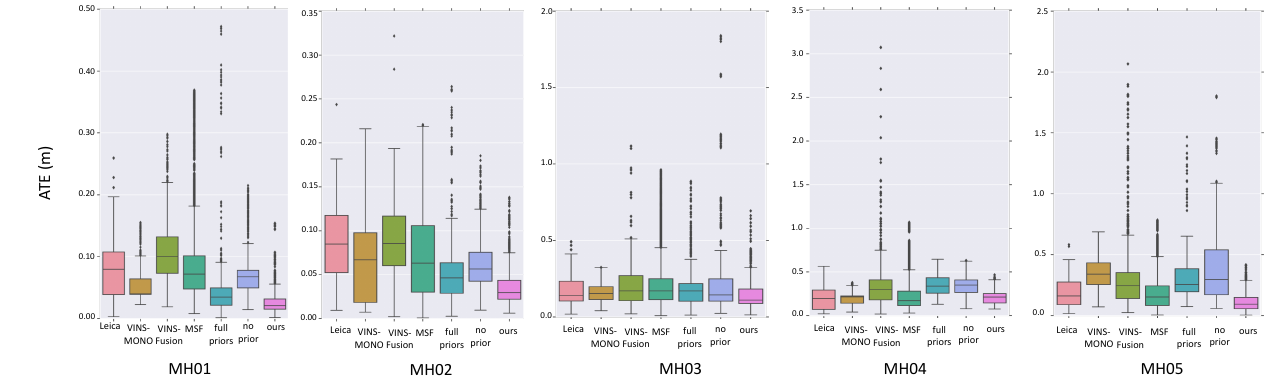
Figure 5. The average trajectory errors of different localizers tested on EuRoC dataset.